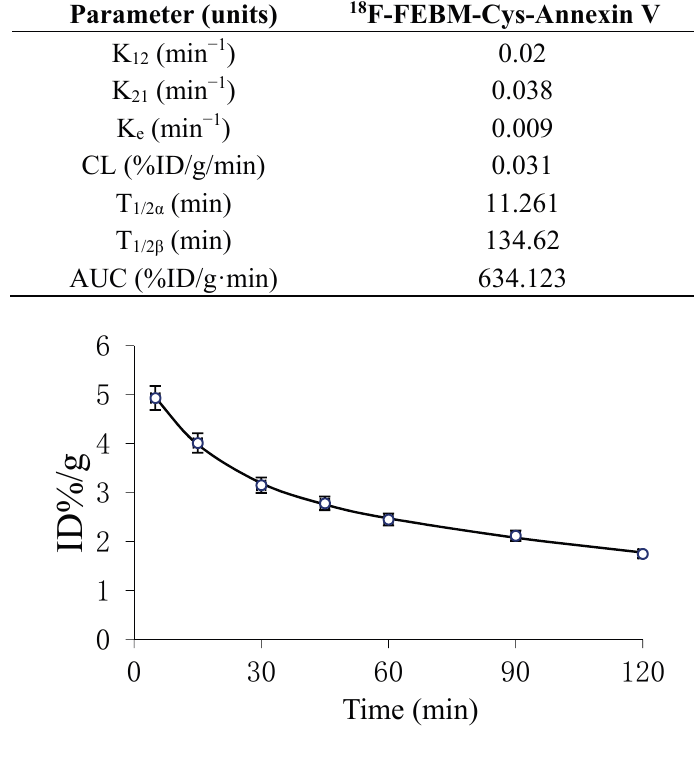
Figure 3. Pharmacokinetic curve for 18 F-FEBM-Cys-Annexin V in